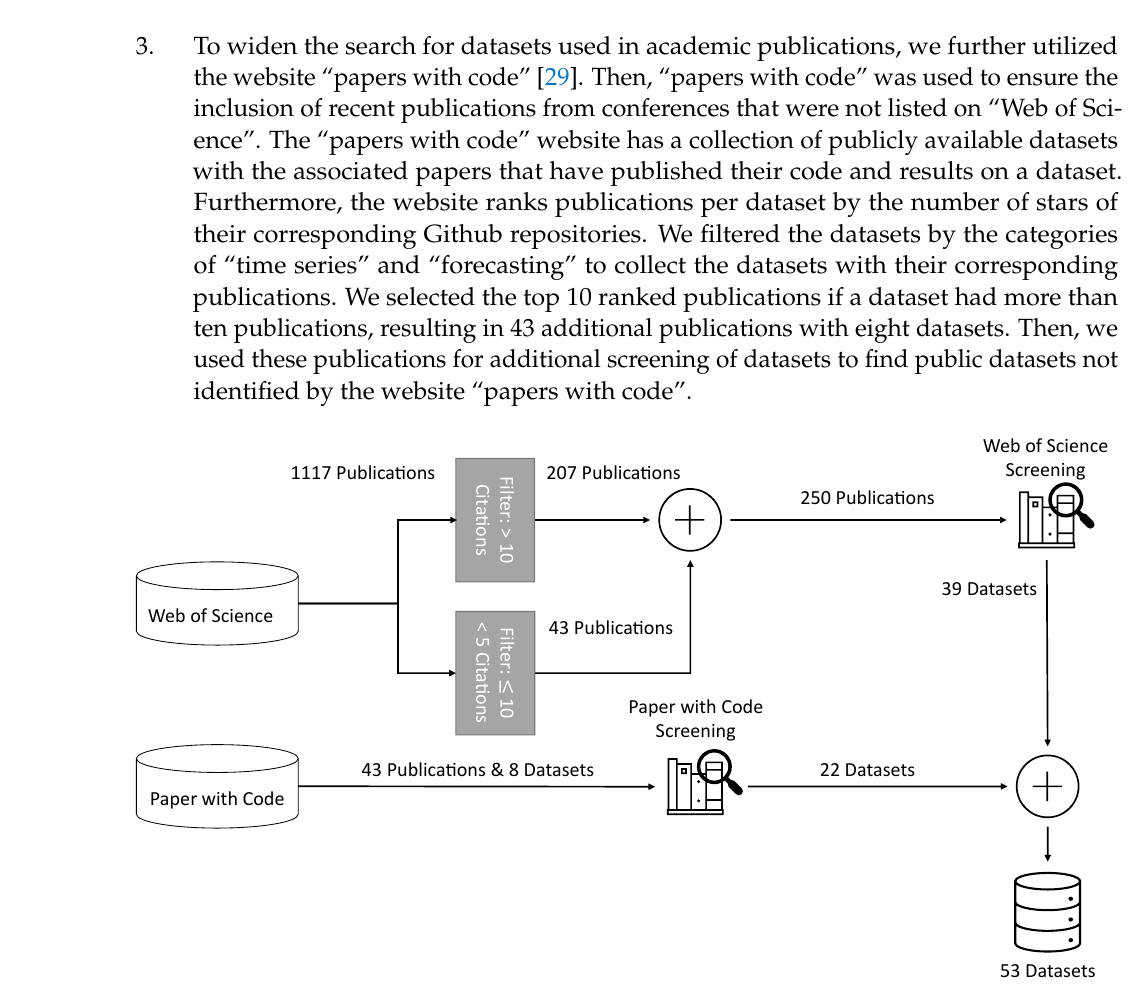
Figure 2. Visualization of the public dataset search process with the number of publications used for the